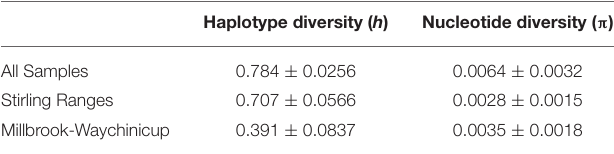
TABLE 2 | Nucleotide and haplotype diversity in populations and regions of Banksia brownii assayed with three chloroplast sequences, the trnV–ndhC , trnQ–rps16 and rpl32–ndhF intergenic spacer regions.